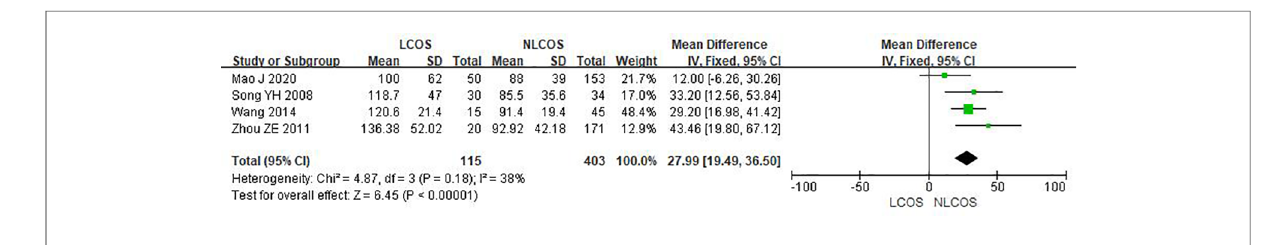
FIGURE 7 Duration of CPB forest